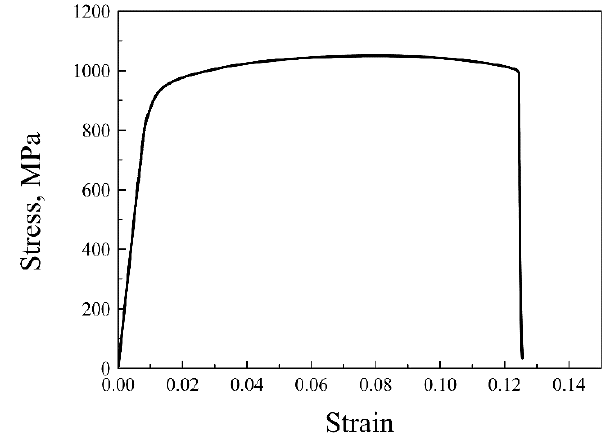
Figure 7. Tensile strain–stress curve of the 14Cr ODS steel at room temperature.